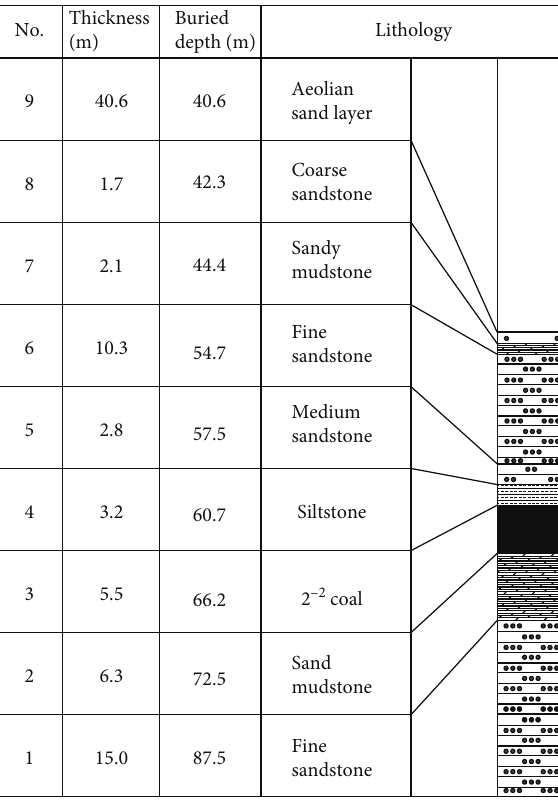
Figure 2: Borehole histogram of 22207